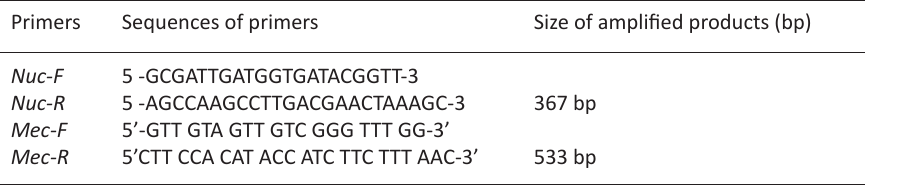
Table 1. Primers used for the molecular detection of nuc and mecA genes Primers Sequences of